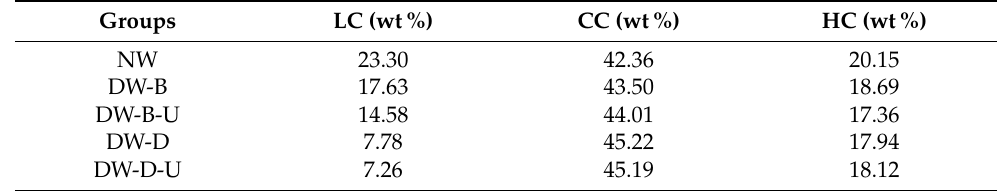
Table 2. Lignin content, cellulose and hemicellulose content of natural wood NW, four groups